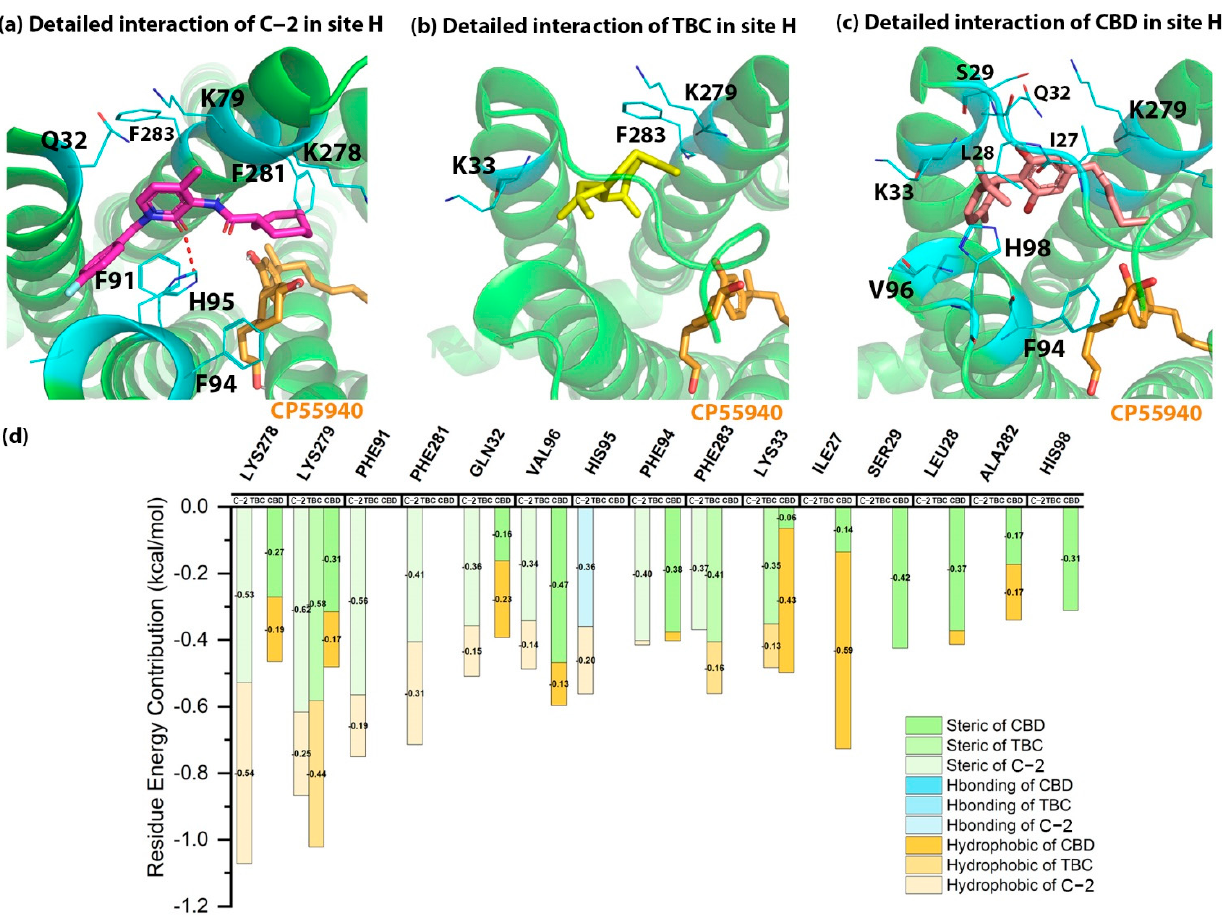
Figure 4. The detailed interactions and residue energy contribution of C-2, TBC and CBD in site H. ( a ) The detailed binding pose of C-2 in site H. ( b ) The detailed binding pose of TBC in site H. ( c ) The detailed binding pose of CBD in site H. ( d ) The comparisons of residue energy contribution of these AMs in site H.